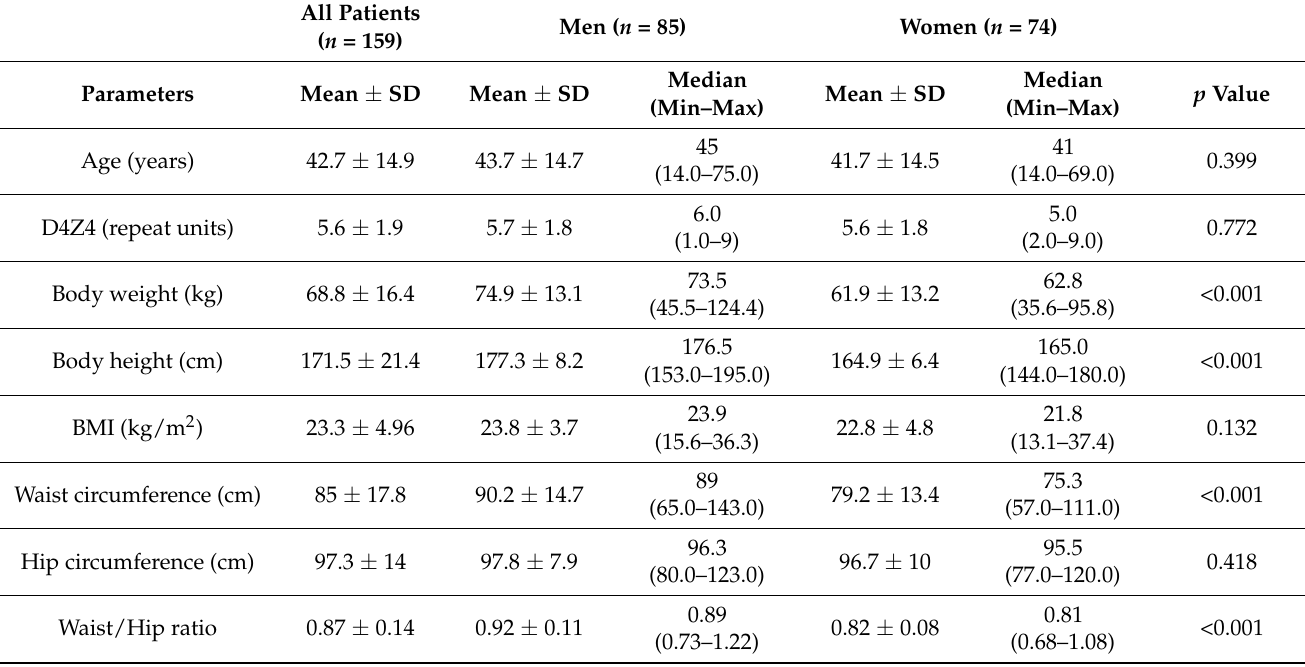
Table 1. Demographic, clinical, and anthropometric characteristics of patients with FSHD. SD,